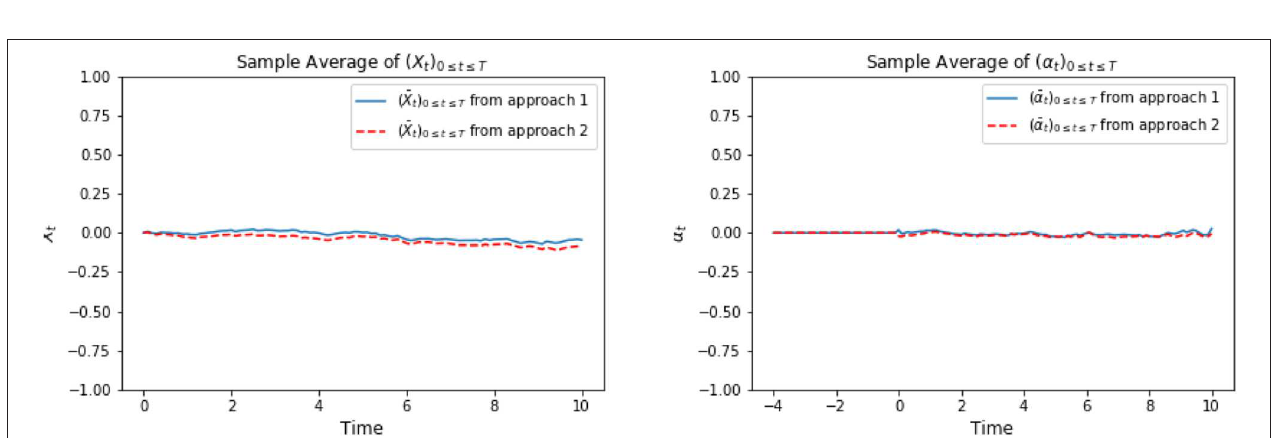
FIGURE 1 | On the left, we compare one representative optimal trajectory of ( X t trajectory of ( α t